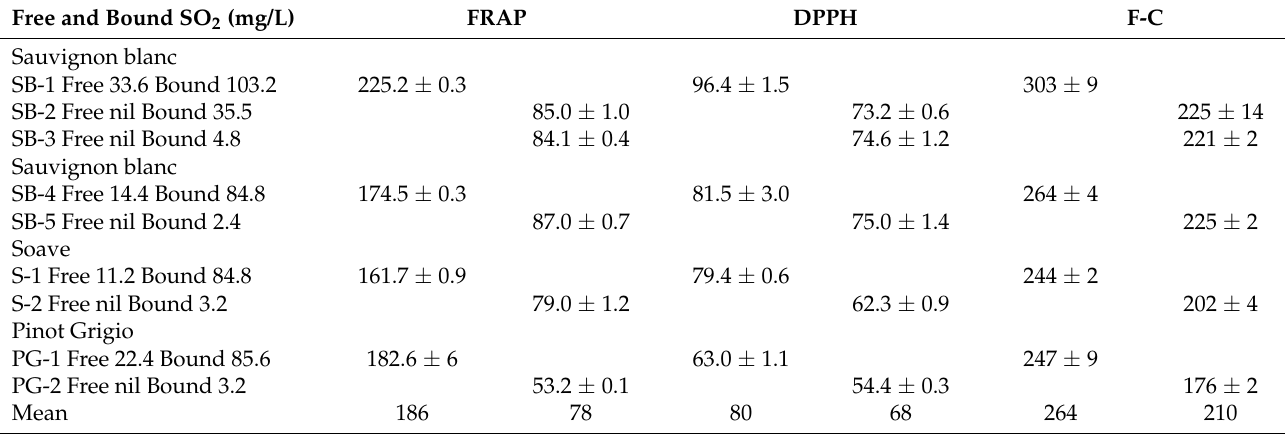
Table 5. Comparison of results obtained with original white wines and after SO 2 was largely removed